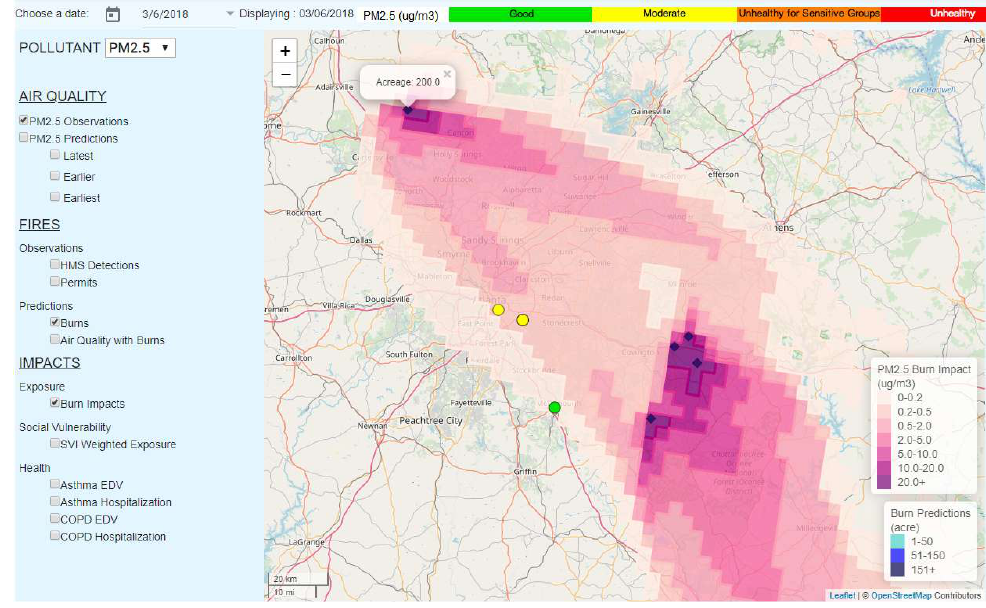
Figure 7. Predicted smoke impacts on populated areas on 6 March 2018.